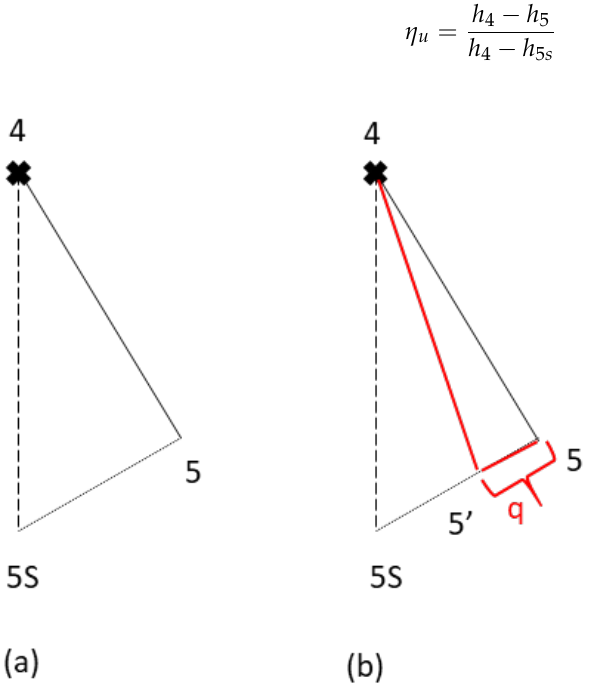
Figure 12. ( a ) Uncooled expansion; ( b ) cooled turbine. h 4 : Specific enthalpy at the inlet of the turbine (kJ/kg) h 5 : Specific enthalpy at the outlet of the turbine (kJ/kg) h 5 s : Specific isentropic enthalpy at the outlet of the turbine